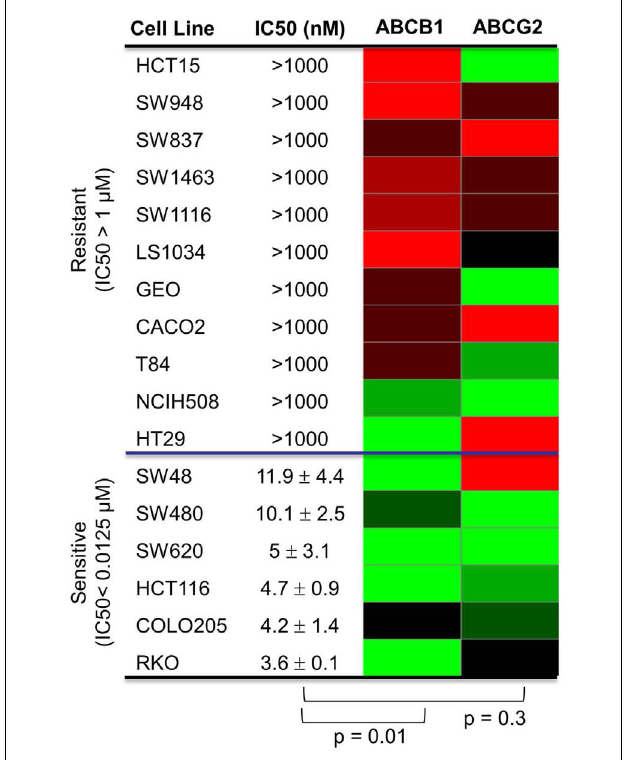
FIGURE 1 | Correlation of ABCB1 and ABCG2 expression and resistance in a panel of CRC cell lines. Anti-proliferative effects of PF-309 was determined in CRC cell lines treated with various concentrations for 72h by SRB assay. Cell line IC50 values were calculated and values below 12.5nM were classified as sensitive and cell lines with an IC50 greater than 1 µ M were classified as resistant ( ∼ 100-fold difference in activity). A heatmap for ABCB1 and ABCG2 expression in the panel of lines was generated (red represents high expression and green represents low). Spearman correlation of ABCB1 relative expression and IC50 values showed a significant correlation ( p = 0.01) while ABCG2 relative expression did not correlate with activity ( p =